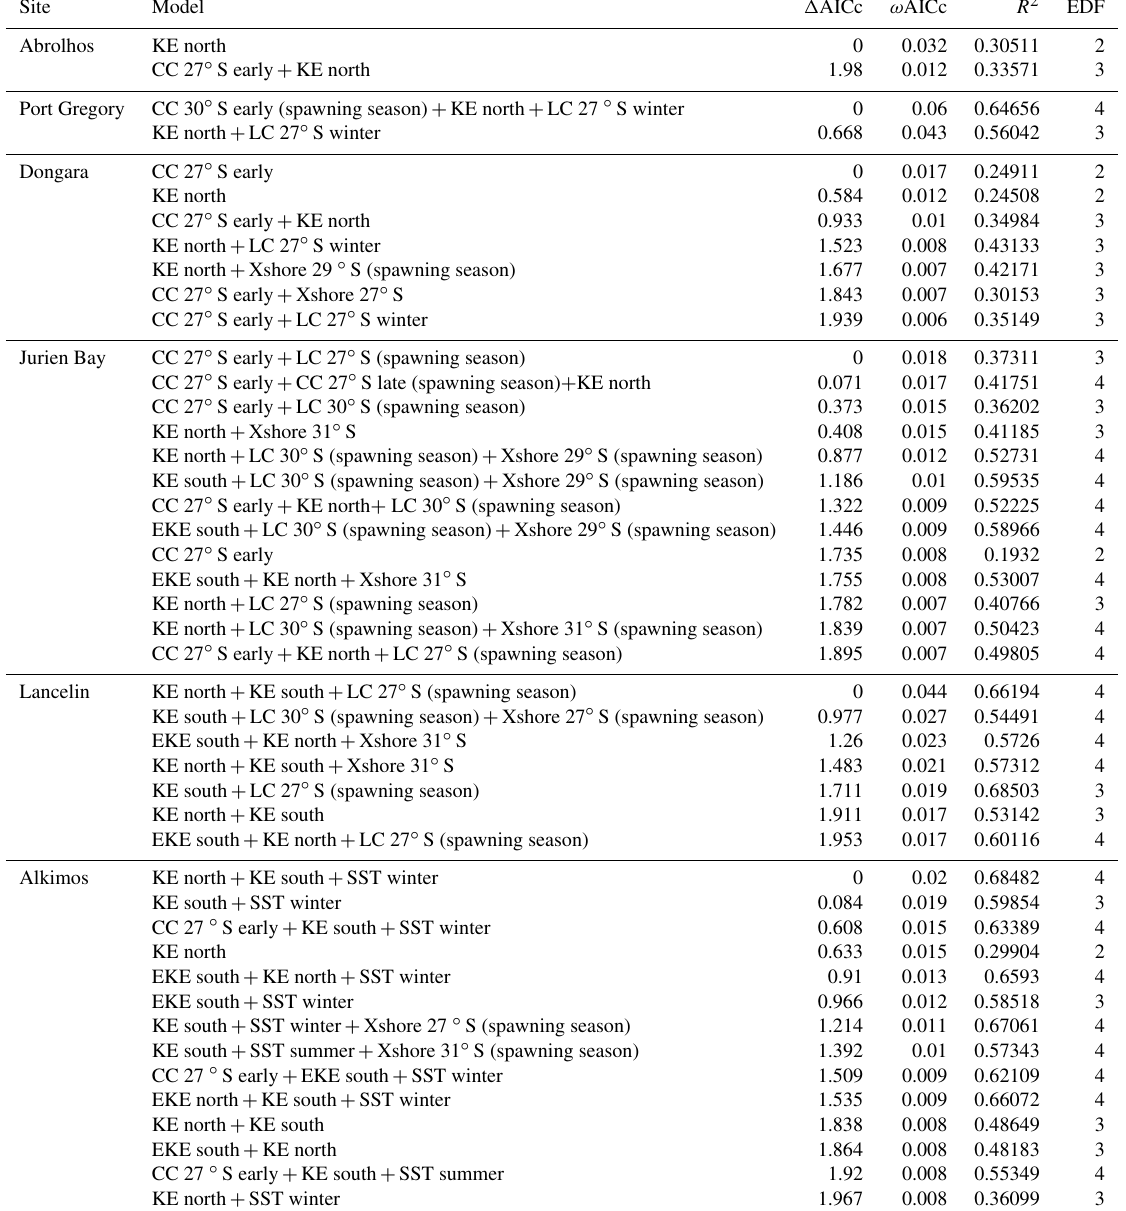
Table B1. Top generalized additive models (GAMs) for predicting the early puerulus settlement at the eight sites from full subset analyses. Differences between lowest reported corrected Akaike information criterion ( (cid:49) AICc), AICc weight ( ω AICc), variance explained ( R 2 ) , and effective degrees of freedom (EDF) are reported for model comparison. Model selection was based on the most parsimonious model (fewest variables) within two units of the lowest AICc, and models are ordered by